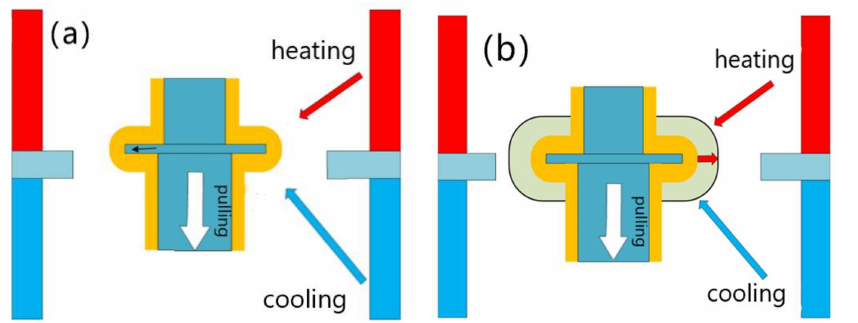
Figure 9. Schematic diagram of heat exchange between the platform and the furnace: ( a ) equal wall thickness shell; ( b ) variable wall thickness mold.